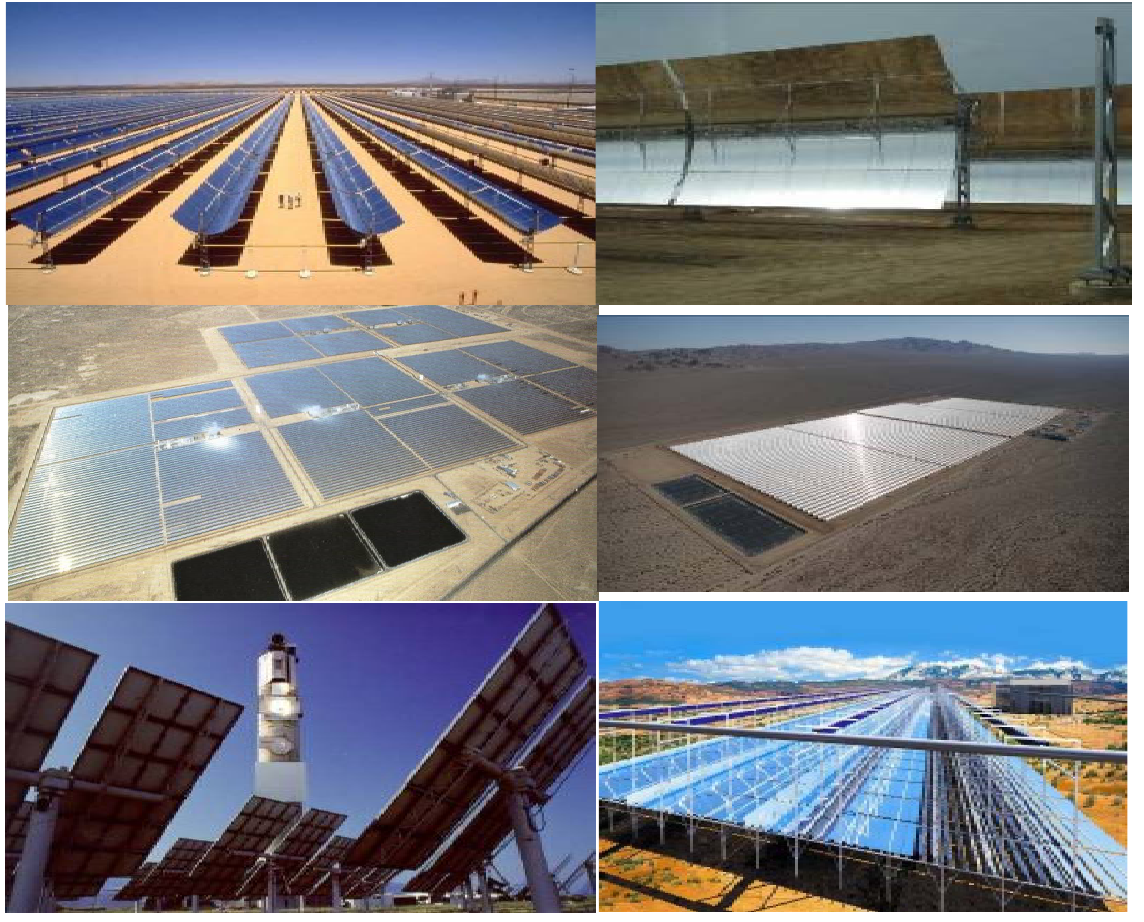
Figure 66. Parabolic troughs (top row), parabolic trough plants (middle row) SEGS (left) and Nevada Solar One (right), central receiver Planta Solar (bottow left) and Linear Fresnel plant (bottom right), both in Spain. Figure reproduced from [282] with